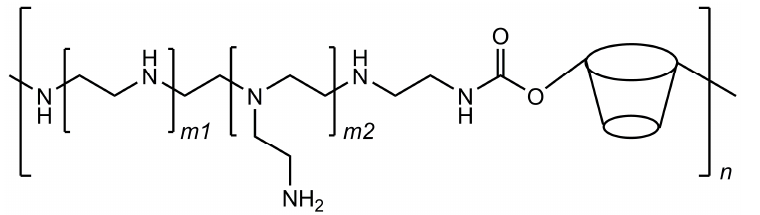
Figure 8. Structural representation of the cyclodextrin–polyethyleneimine conjugated polymer; the ratio of cyclodextrin residues in the polymer can be tuned by varying the length at the m 1 and m 2